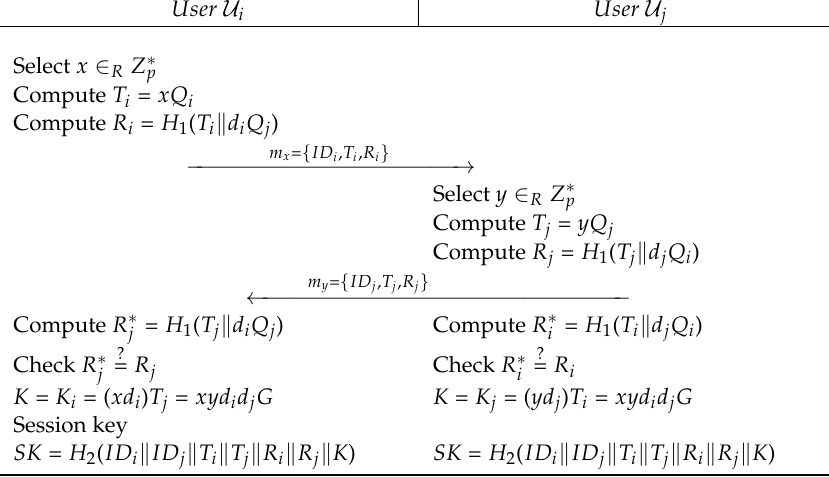
Figure 2. Islam-Biswas Key Agreement